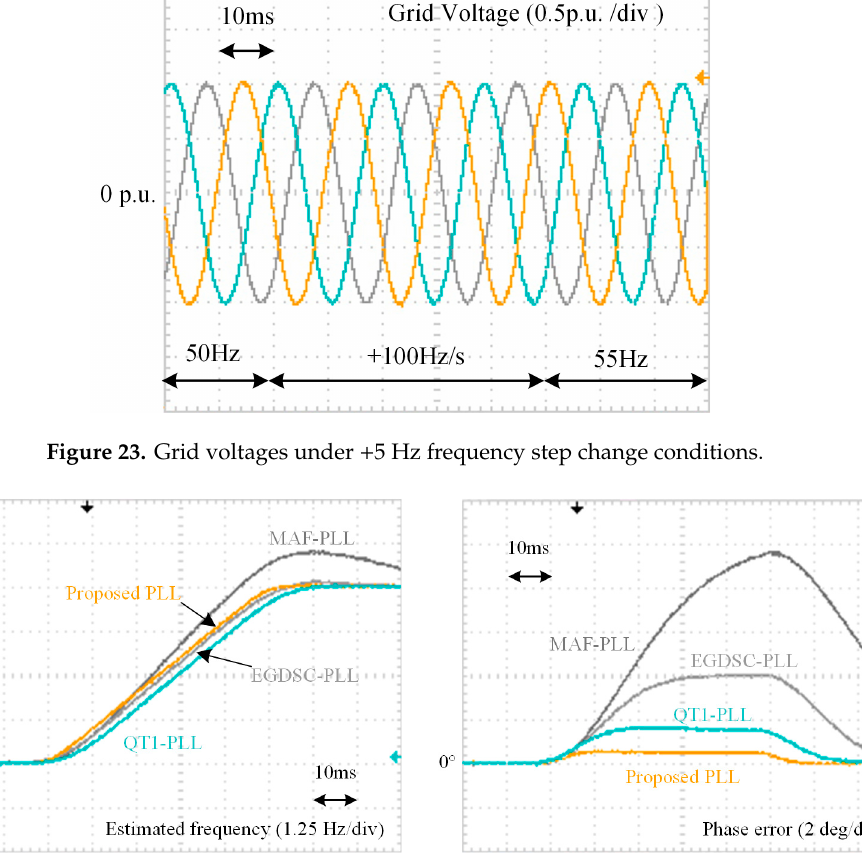
Figure 24. The experimental results of test case 3. ( a ) Estimated frequency and ( b ) phase error.